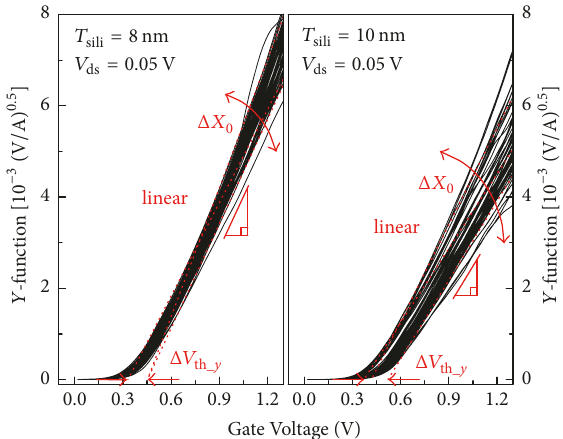
Figure 3: 𝑌 -function variations of the SOI FinFETs with 𝑇 and 10nm. Almost all the 𝑌 -functions satisfy the linearity condition in the strong inversion